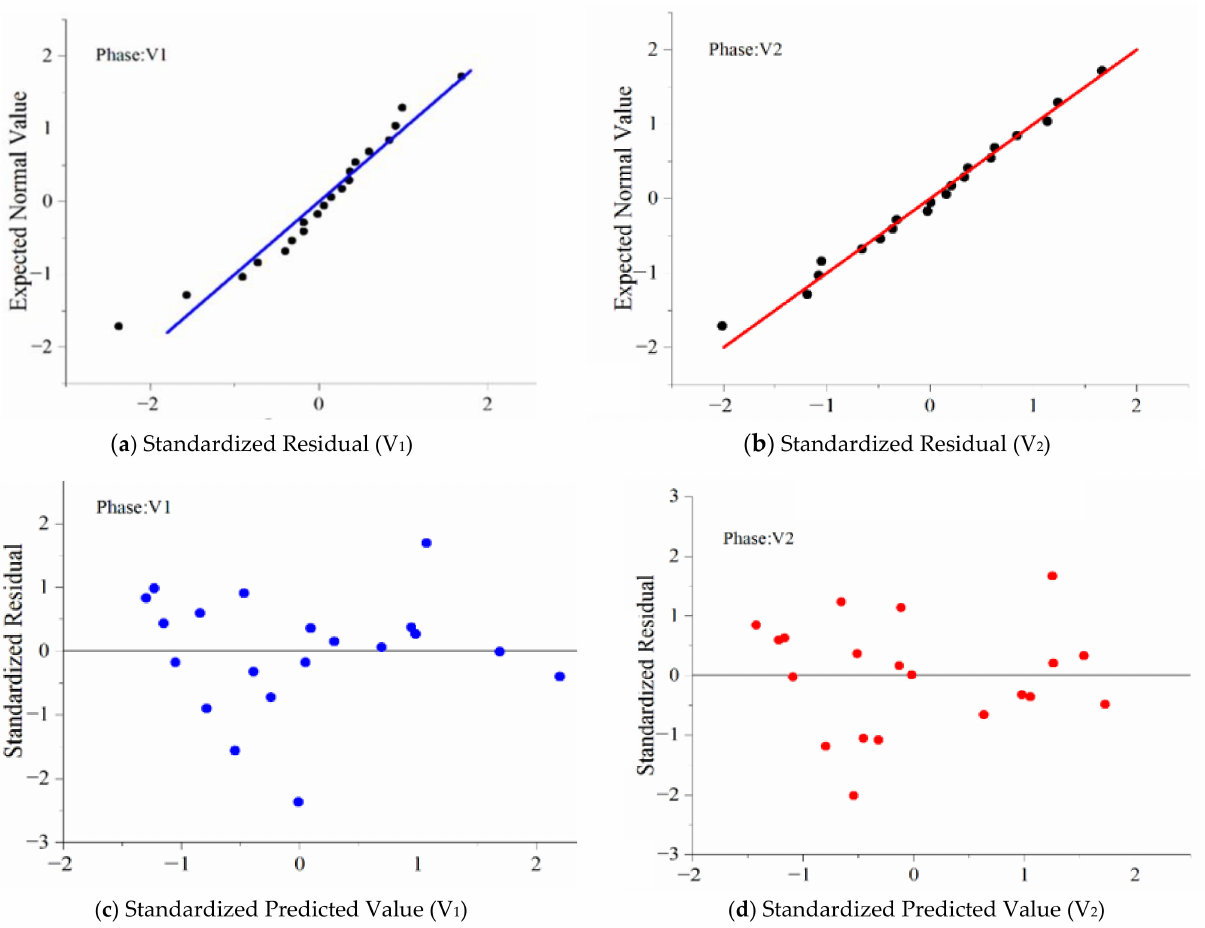
Figure 9. Normal Q-Q plot and scatterplot of the regression standardized residual of